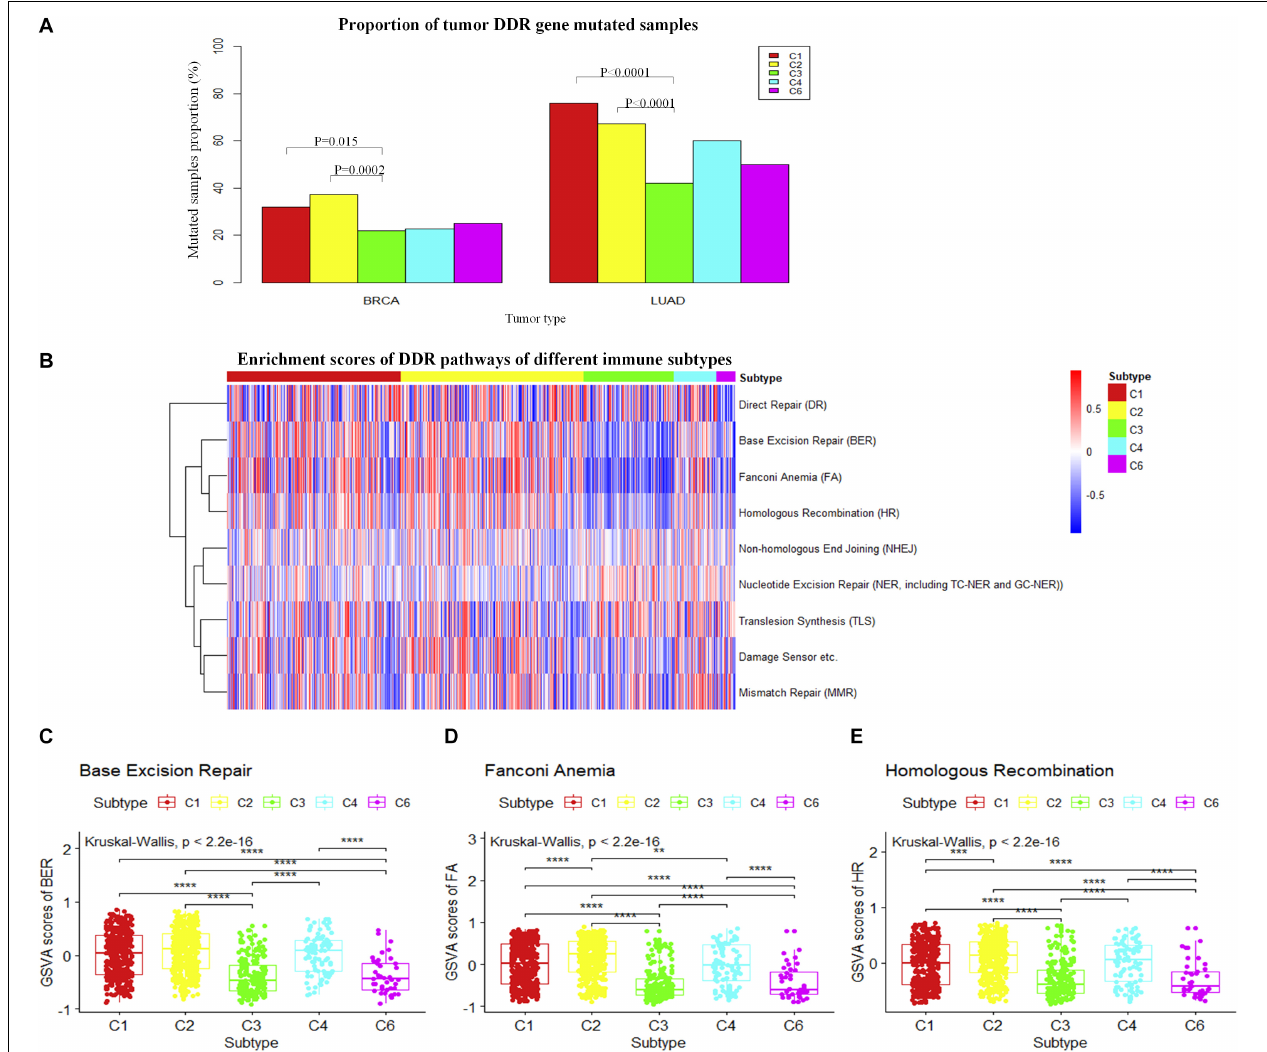
FIGURE 2 | Relationship between immune subtypes and DNA damage repair (DDR) in breast invasive carcinoma. (A) The histogram shows the proportion of DDR gene mutations in different immune subtypes. (B) The heatmap shows the single-sample gene set variation analysis (ssGSVA) enrichment scores for DDR pathways from immune subtypes. (C–E) The boxplot shows the enrichment scores for breast invasive carcinoma immune subtypes in three DDR pathways (Wilcoxon rank-sum test was used. * P < 0.05, ** P < 0.01, *** P < 0.001, **** P < 0.0001).